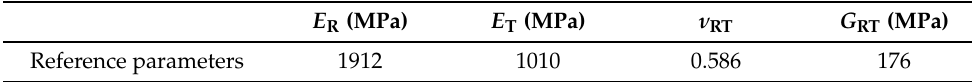
Table 3. Reference constitutive parameters for Pinus pinaster